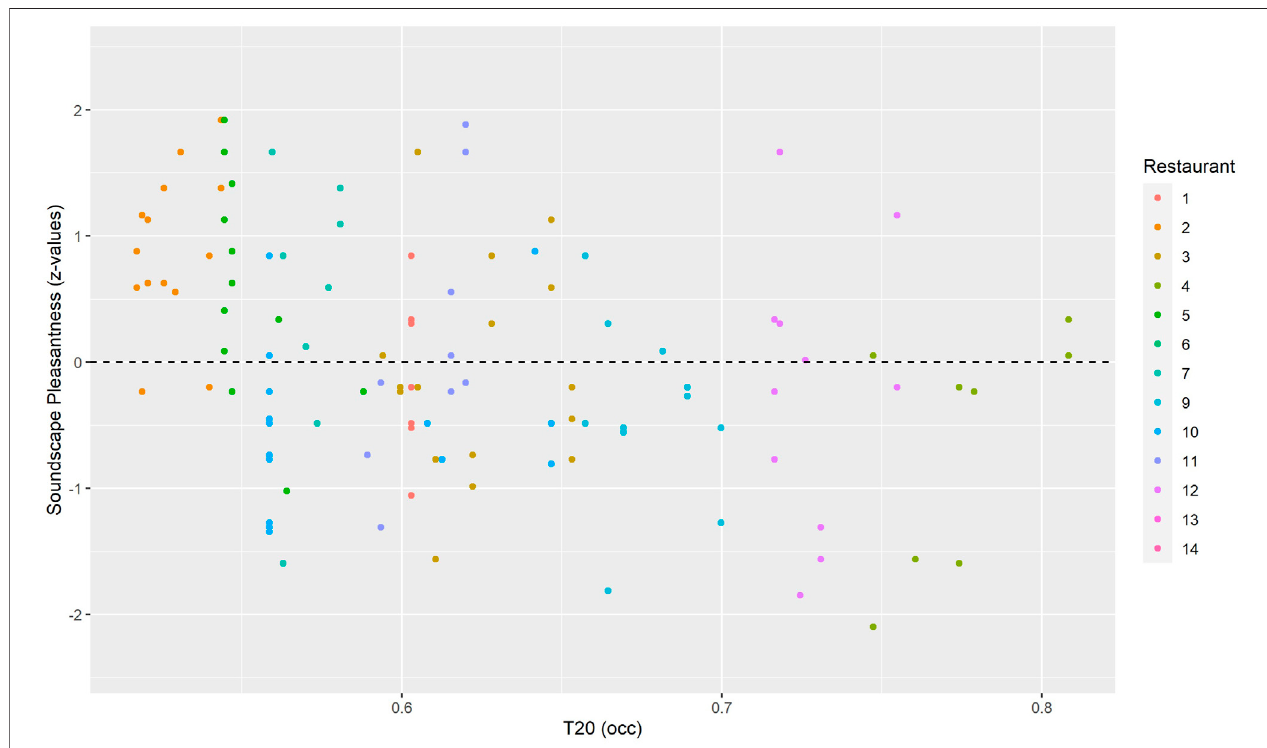
FIGURE 3 | T 20,occ values and z-standardized soundscape pleasantness judgements.